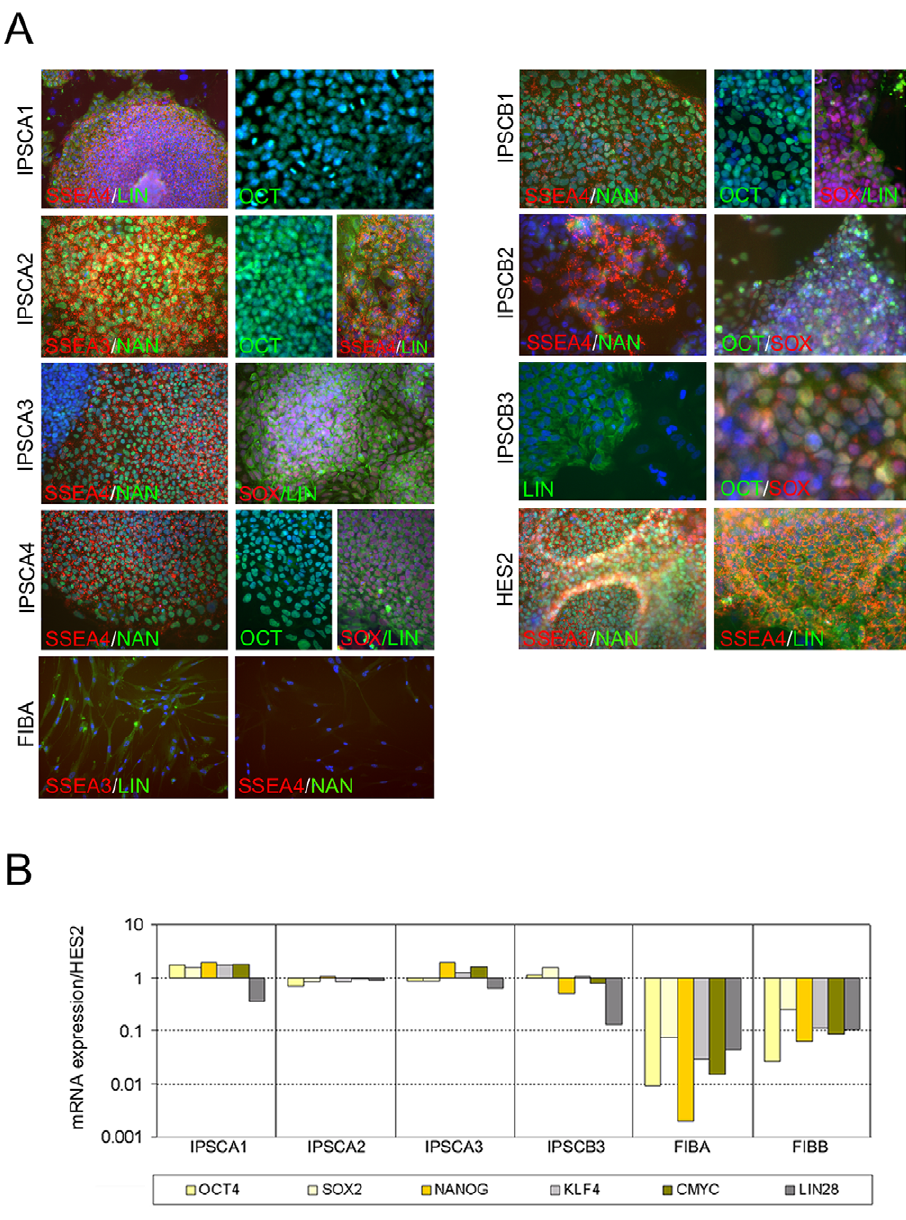
Figure 3. Indicators of cell phenotype and pluripotency in IPSC lines. (A) Immunofluorescent analysis of pluripotency markers as labeled. Label color corresponds to marker color in images. Blue staining in all panels is DAPI labeling of nuclei. All IPSC lines displayed strong positive expression of pluripotency markers that were not observed at high levels in input FIB cells with the exception of the Lin28 antibody that reproducibly produced faint fluorescence in the cytoplasm of fibroblasts. (B) Representative QPCR analysis of FIB lines and reprogrammed IPSCs for markers of pluripotency and reprogramming factors relative to factor levels in hESCs. Input fibroblasts express very low levels of most factors whereas IPSCs display levels very similar to